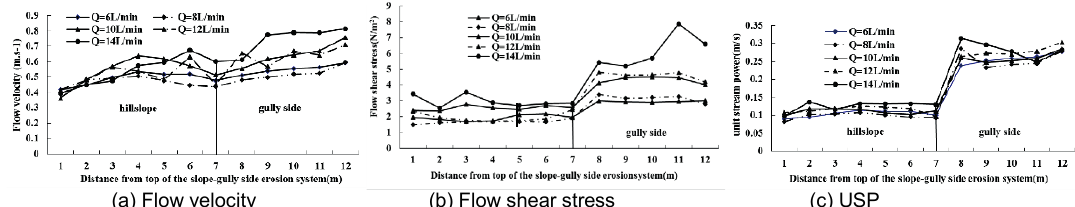
Fig. 2 Longitudinal variations of flow velocity, flow shear stress and flow unit stream power